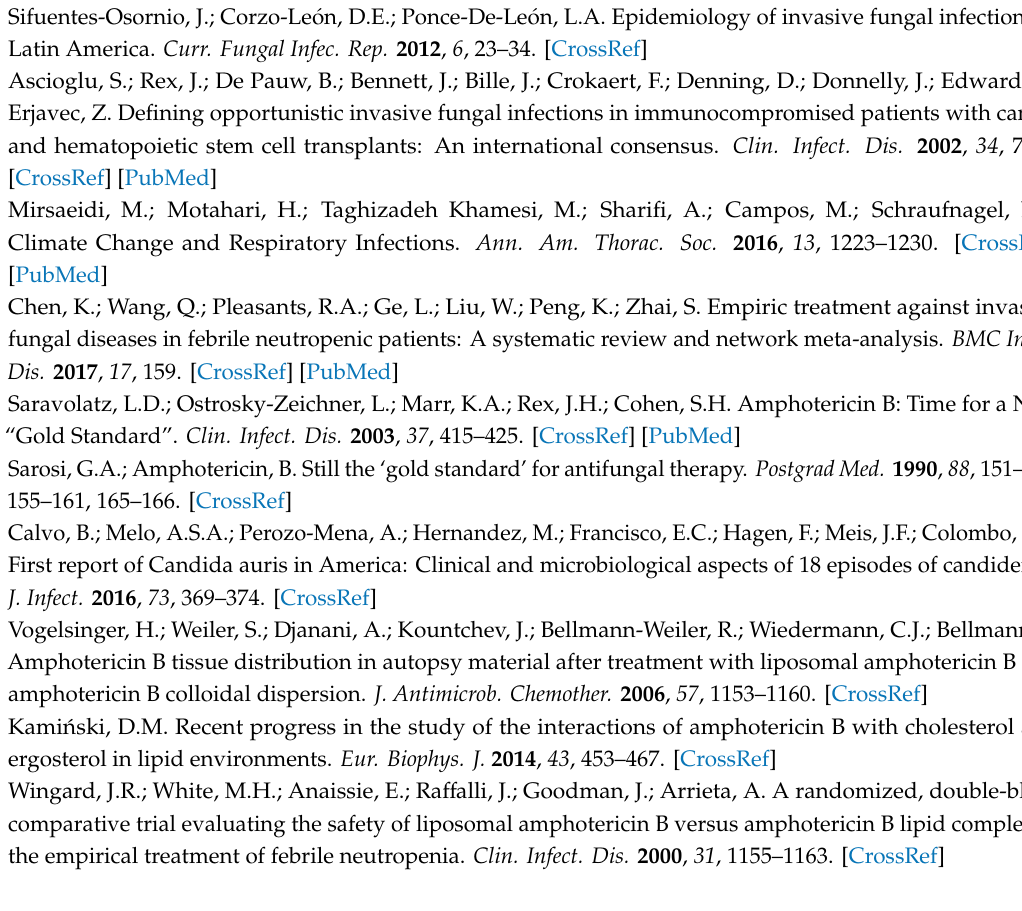
Figure S1. 1H-NMR spectra of A. ABA and B. ABA-Succinic acid copolymers. Figure S2. TEM image of micellar dispersion of sample AmB@ABA-RET showing the presence of spherical nanoparticles. Figure S3. Plot of relative haemolysis of each formulation at the concentration of 3.8 µ g / mL versus its corresponding aggregation ratio value listed in Table 5, Figure S4. Determination of MIC employing resazurin. Figure S5. Growing curves of C. auris 537 in the presence of di ff erent concentrations of AmB@PMs, Table S1. Release